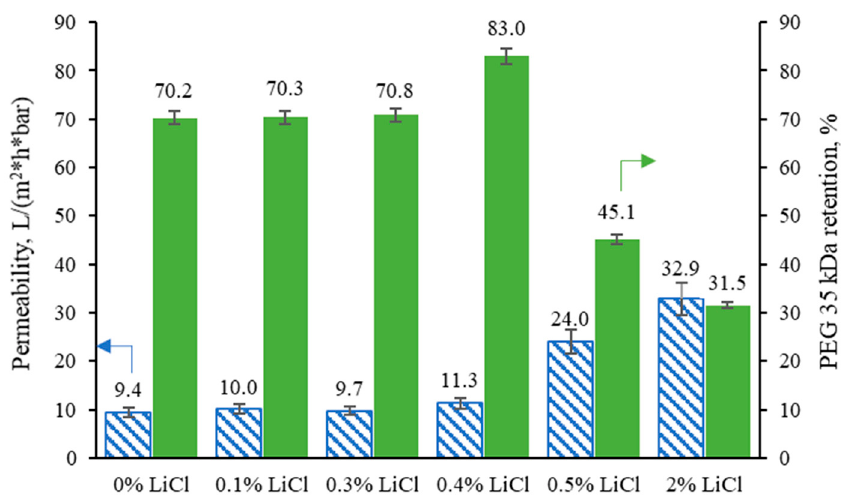
Figure 9. Pure water permeability values were measured at 1 bar, and PEG 35 kDa of the tested membranes was measured in an Amicon ultrafiltration cell at 25 °C and a mixing rate of approximately 300 rpm.